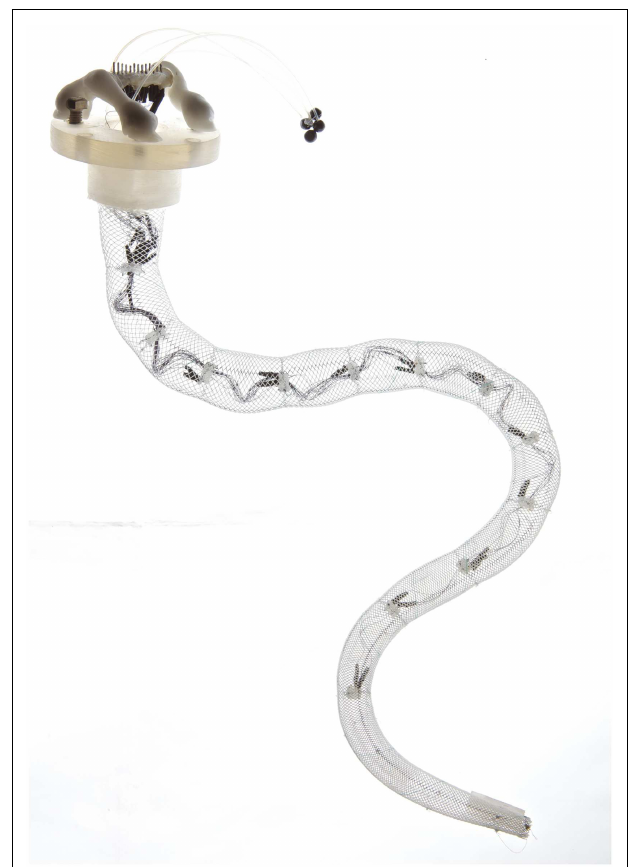
FIGURE 2 | Flexible octopus-like robot arm, composed by a braided sheath actuated by SMA springs (photo by Massimo Brega,The Lighthouse)